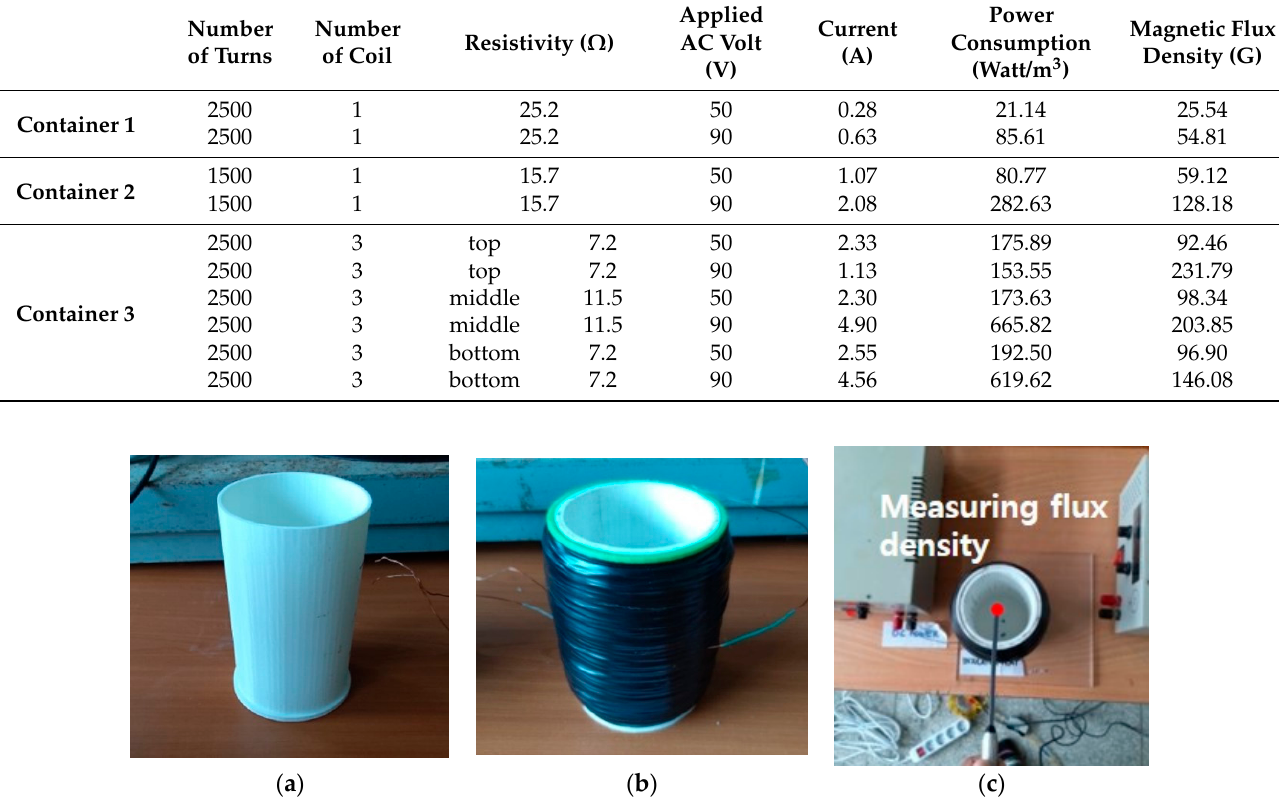
Figure 2. Plastic container for magnetic field: ( a ) before winding coils, ( b ) after winding coils, ( c ) measuring location of flux density.